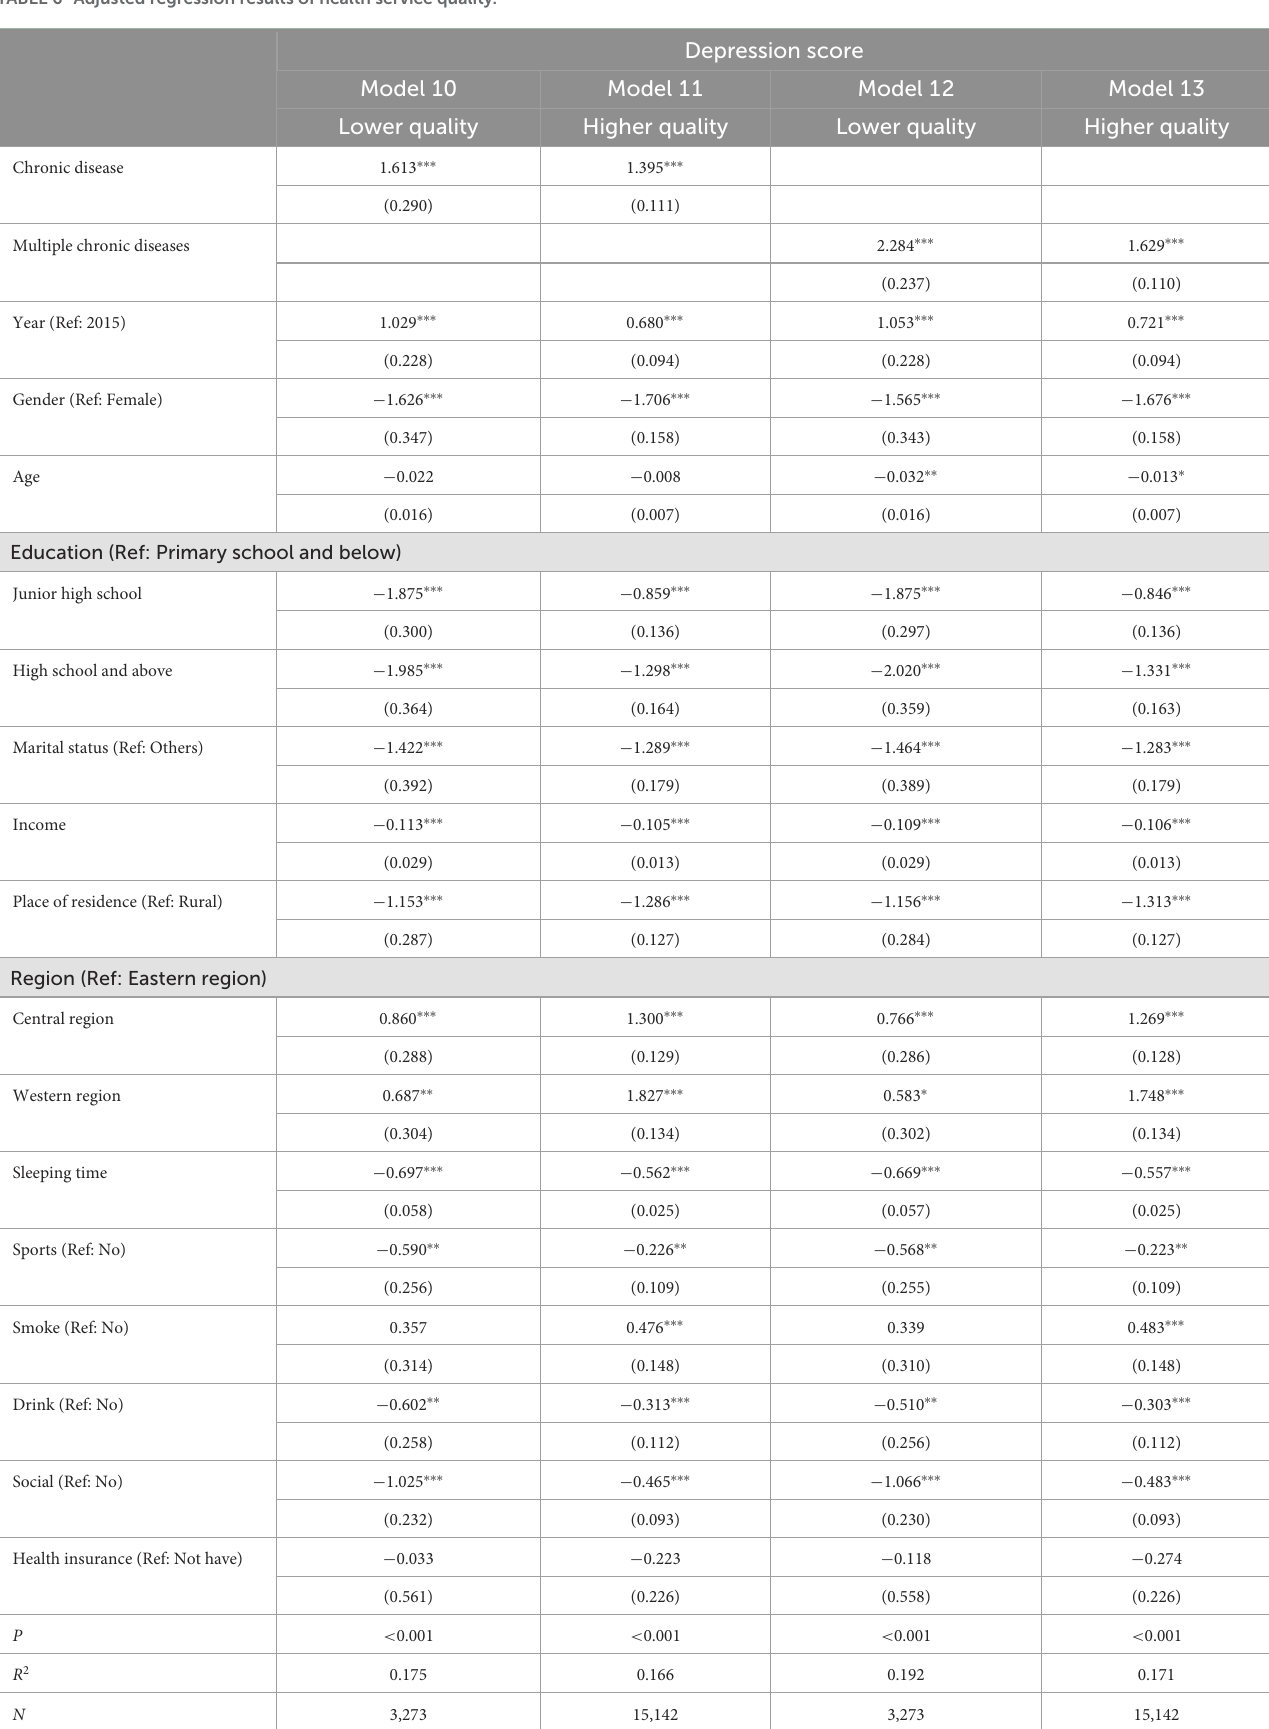
TABLE 6 Adjusted regression results of health service